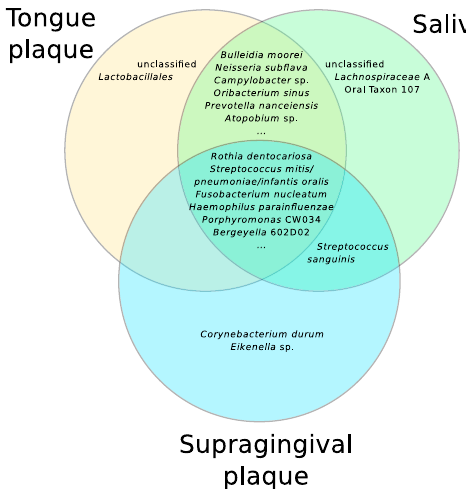
Fig. 3 Venn diagram showing the taxonomic classi fi cations of some of the core OTUs present within ≥ 95% of the samples in the indicated subsets of oral sites. For example, Bulleidia moorei was found in ≥ 95% of tongue plaque and saliva samples, but < 95% of supragingival plaque samples, while Rothia dentocariosa was found in ≥ 95% of the samples from all three sites. This list is not exhaustive; see Supplementary File 1 for a complete